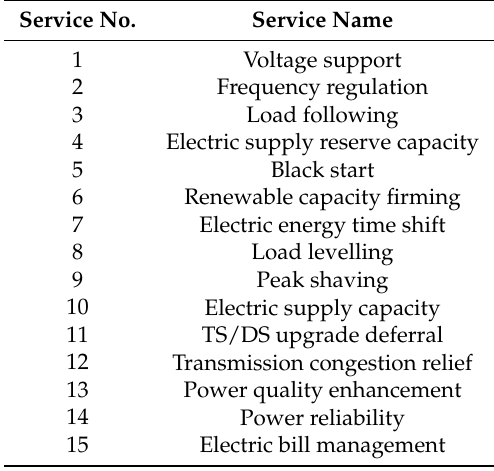
Table 1. List of ancillary services provided by BESSs for the projects included in Table A1. Service No.